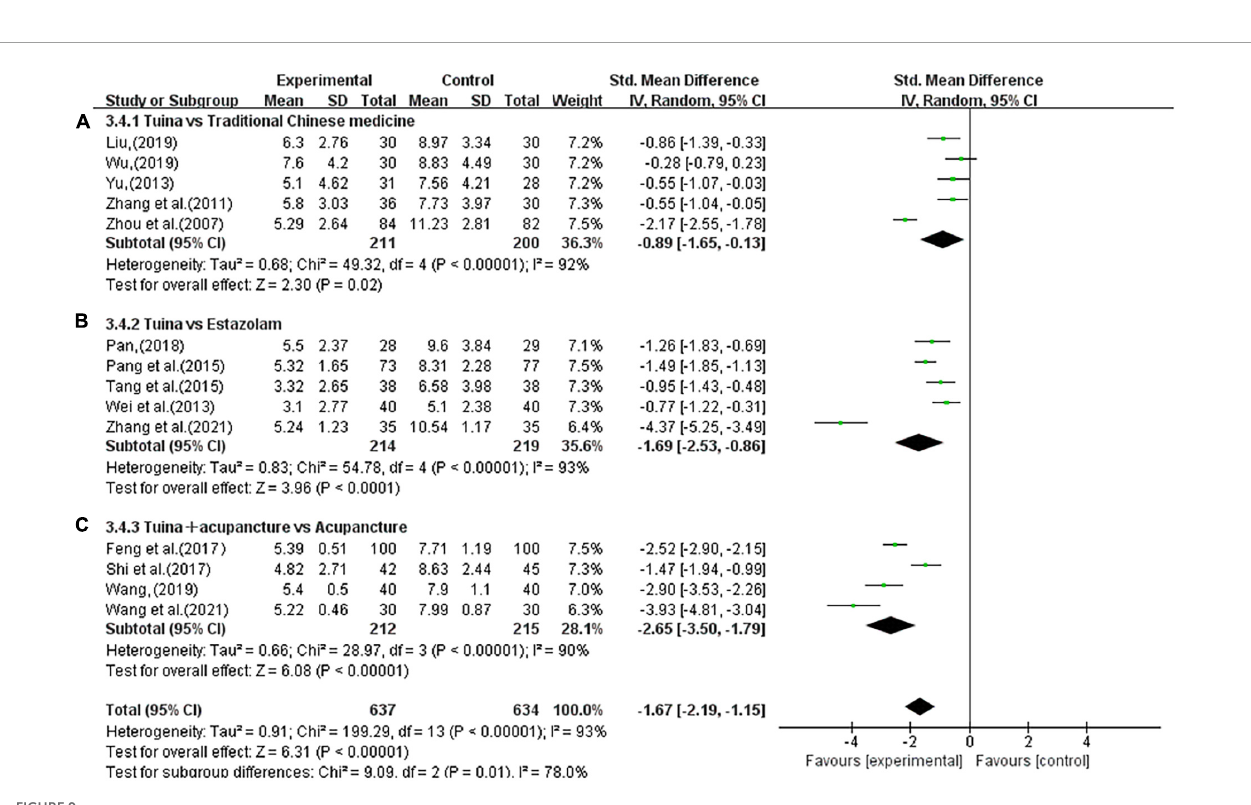
FIGURE9 Subgroup analysis of tuina and different interventions in Pittsburgh Sleep Quality Index (PSQI). (A) Traditional Chinese Medicine (TCM). (B) Estazolam. (C)